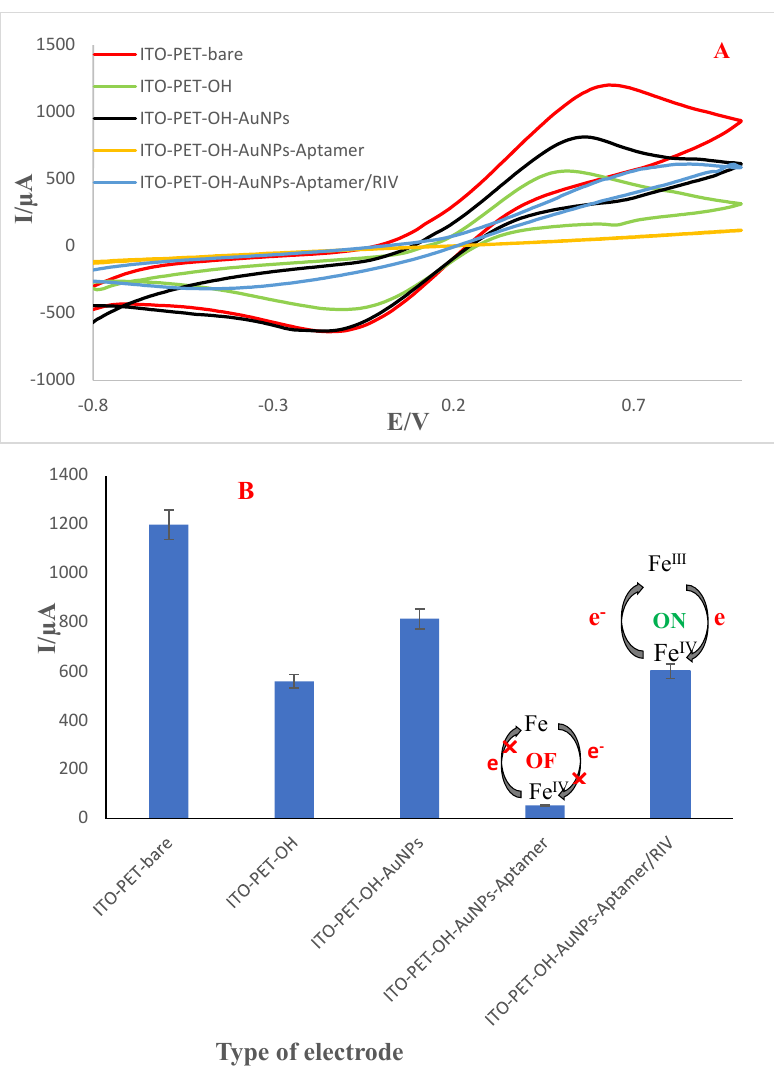
Figure 1. ( A ) CVs of bare ITO-PET, ITO-PET-OH, ITO PET-OH-AuNPs, ITO PET-OH-AuNPs-aptamer, and ITO PET-OH-AuNPs-aptamer/RIV in the presence of ferrocyanide/ferricyanide/KCl (0.01 M) at the potential range of − 1 to +1 V and at a sweep rate of 100 mVs − 1 . ( B ) Histogram of peak currents versus the type of electrode. (n =